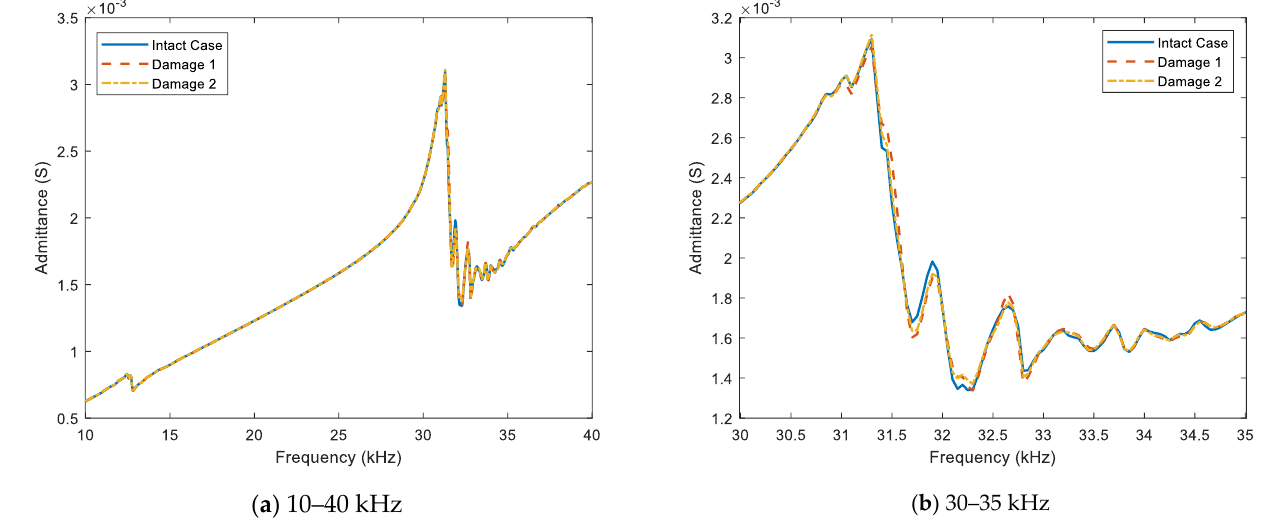
Figure 9. Measured admittance responses under damage cases: damage distant from the transducer (the first test scenario).